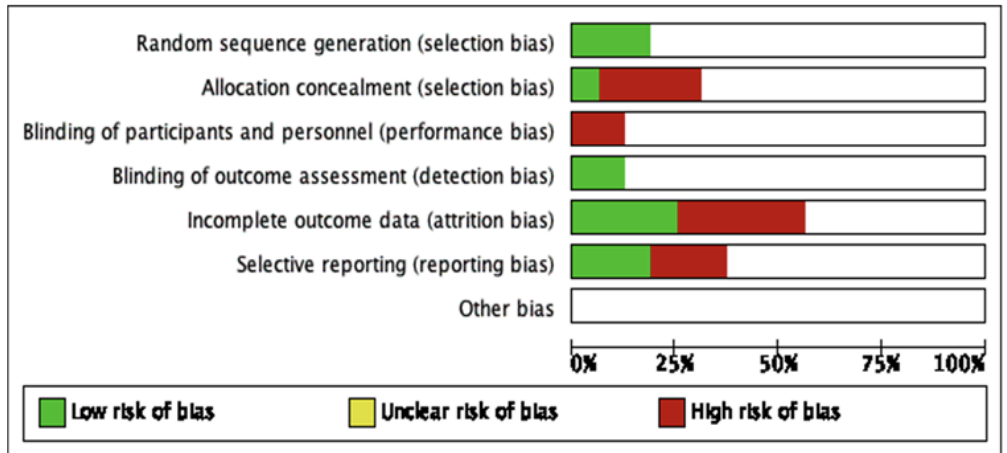
Figure 3. The summary of risk of bias of included studies.